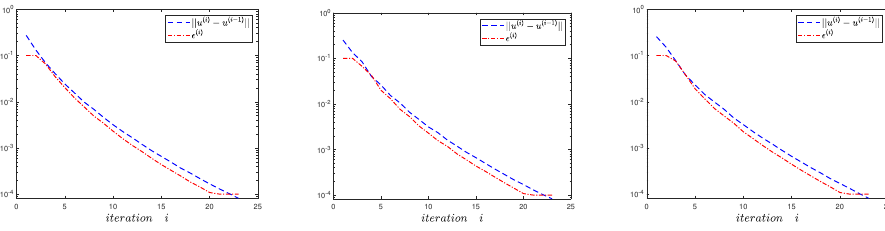
Figure 5. The changing process of (cid:101) ( i ) and || u ( i ) − u ( i − 1 ) || L 2 [ 0, T ] with iteration number i (Left: σ = 0.1. Middle σ = 3. Right: σ = 5).